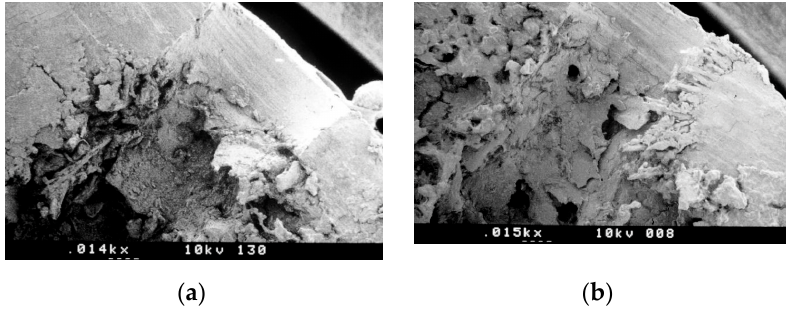
Figure 2. SEM analysis of a drill implant site preparation: ( a ) Drill group shows signs of trauma as a result of drilling, which were also seen in trabecular bone. Bone trabeculae seemed fractured and not precisely cut. ( b ) SEM micrograph magnification shows some large bone chips that had detached from the walls of the implant site during drill preparation; these were packed into the medullary spaces of the trabecular bone, often filling most of the available space.